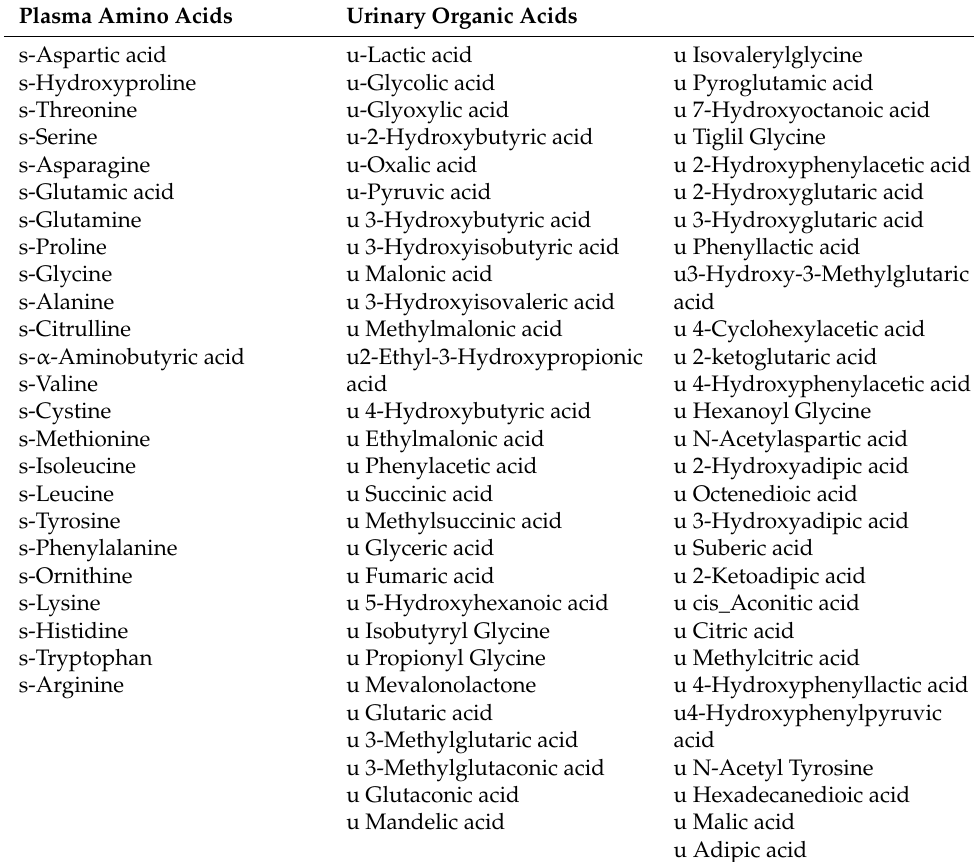
Table 3. Assessed plasma amino acids and urinary organic acids. Plasma Amino Acids